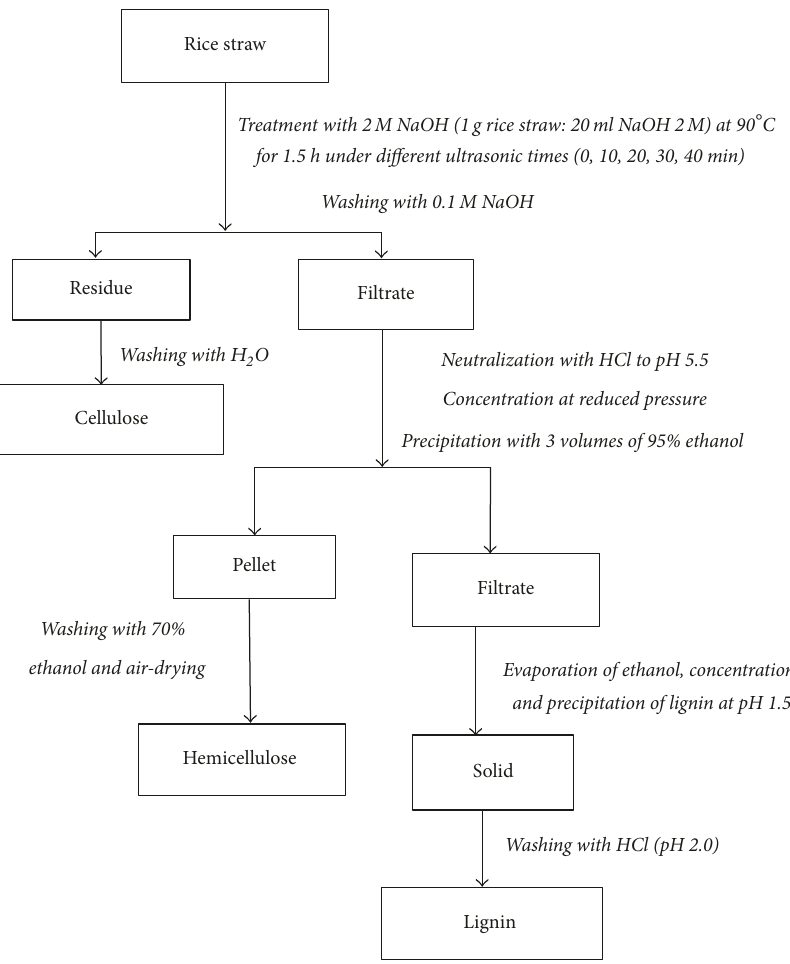
Scheme 1: Ultrasound-assisted extraction method of lignin and